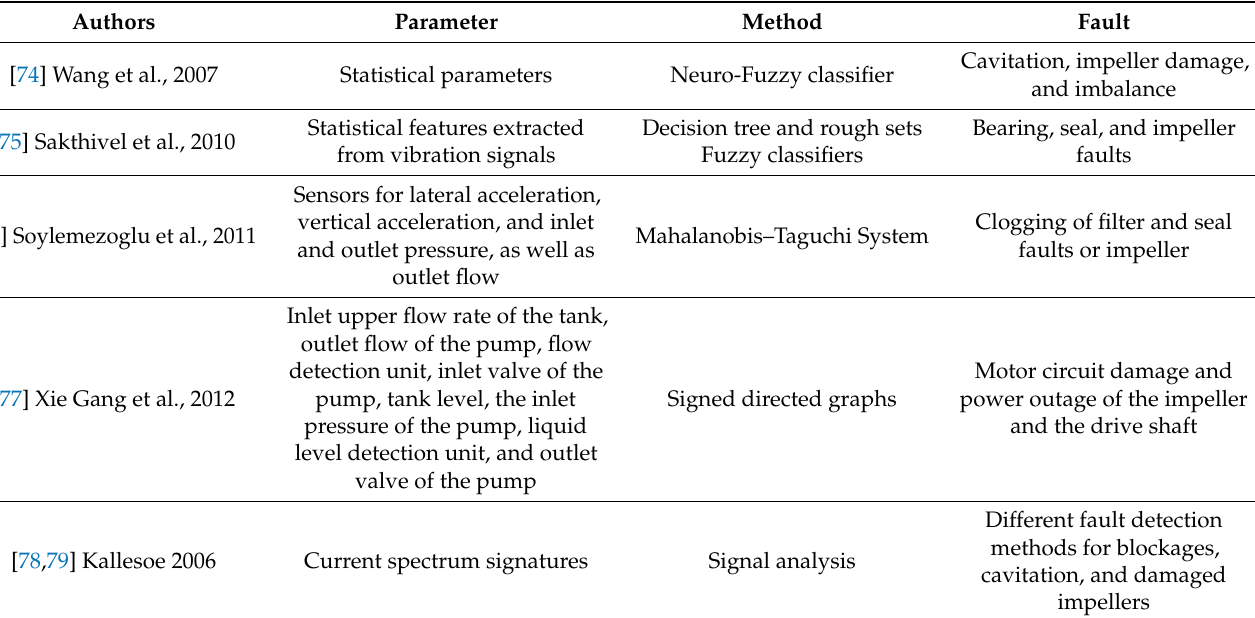
Table 1. Signal-based approaches.